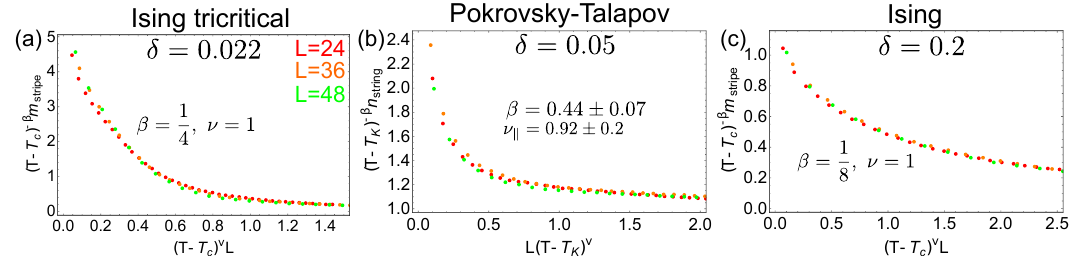
[ Eq. 1 ] . Monte Carlo simulation results are Figure 8: Data collapse close to the critical point for H dip shown for m stripe [ Eq. 2 ] and n string [ Eq. 45 ] on hexagonal clusters of size L = 24 (red), L = 36 (orange) and L = 48 (green). Error bars are in all cases smaller than the point size. (a) In the tricritical region the best data collapse is found for m stripe at δ = 0.022 using the scaling hypothesis given in Eq. 14 with Ising tricritical exponents β = 1 / 4 and ν = 1. (b) Data collapse at δ = 0.05 using the scaling hypothesis given in Eq. 9 for Pokrovsky-Talapov critical behaviour and for exponents that minimise the “goodness of collapse” measure proposed in [ 49 ] . This gives β = 0.44 ± 0.07 and ν (cid:107) = 0.92 ± 0.2, which are consistent with the expected Pokrovsky-Talapov exponents β = 1 / 2 and ν (cid:107) = 1. (c) Data collapse at δ = 0.2 using the scaling hypothesis given in Eq. 14 and the Ising critical exponents β = 1 / 8 and ν =